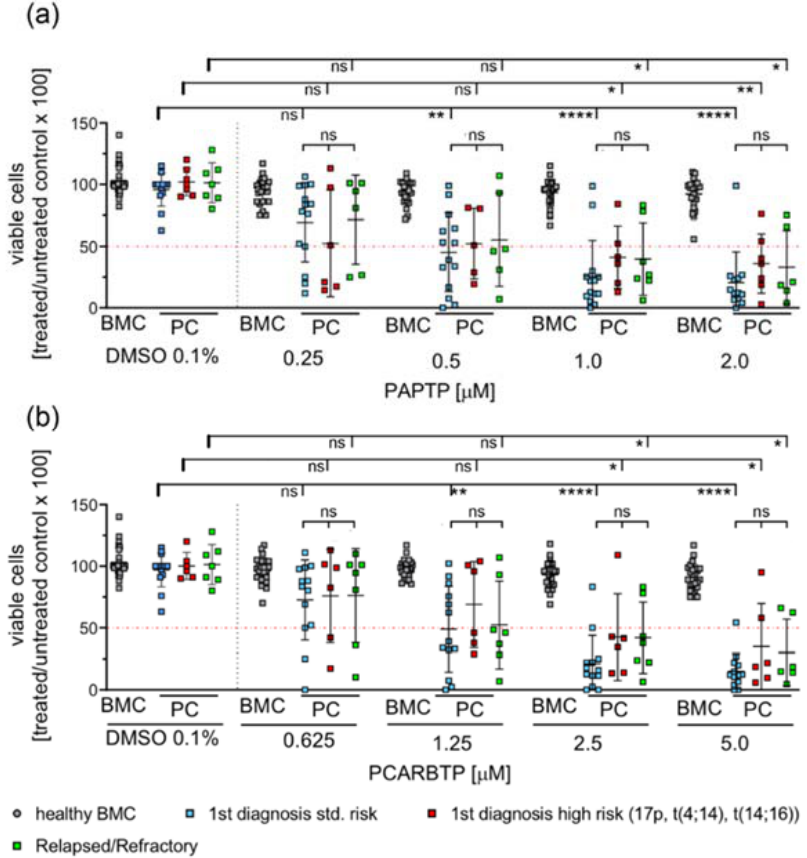
Figure 2. PAPTP and PCARBTP efficiently kill patient-derived myeloma cells ex vivo, while healthy bone marrow cells are spared from toxic effects. Isolated mononuclear bone marrow cells were